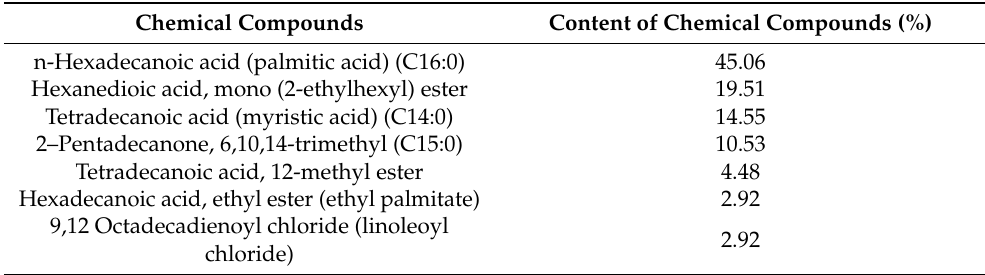
Table 5. Chemical compounds in C. glomerata [39].